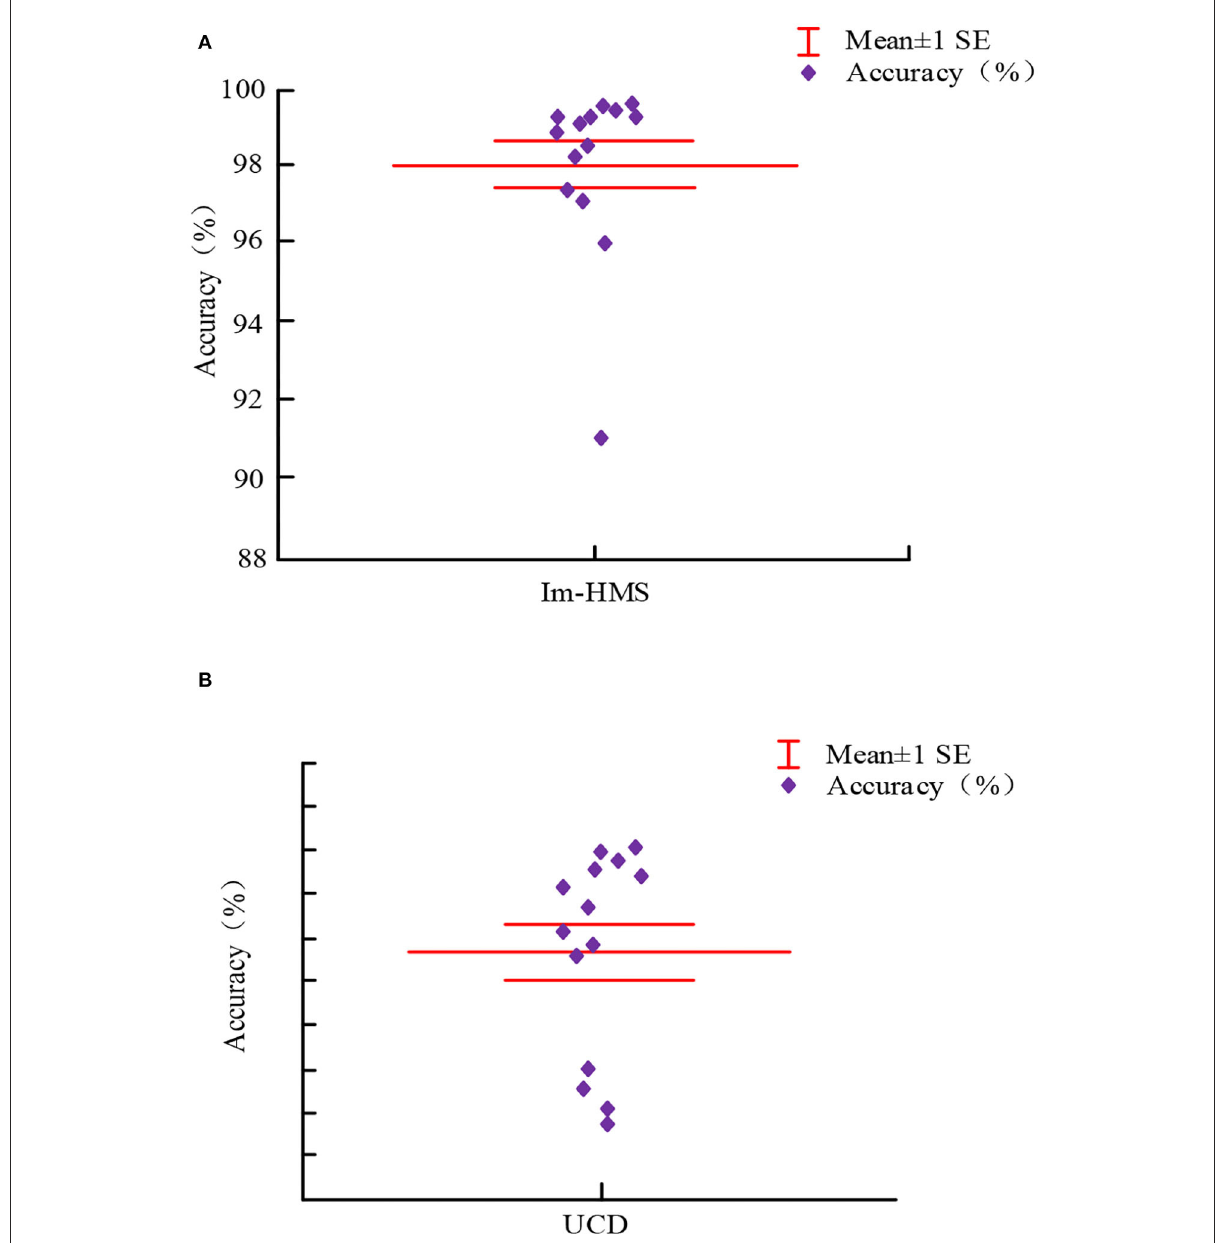
FIGURE5 Accuracy comparison between Im-HMS system and UCD system. (A) Accuracy analysis of the proposed Intelligent m-Health monitoring system (Im-HMS). (B) Accuracy analysis of the existing UCD system.